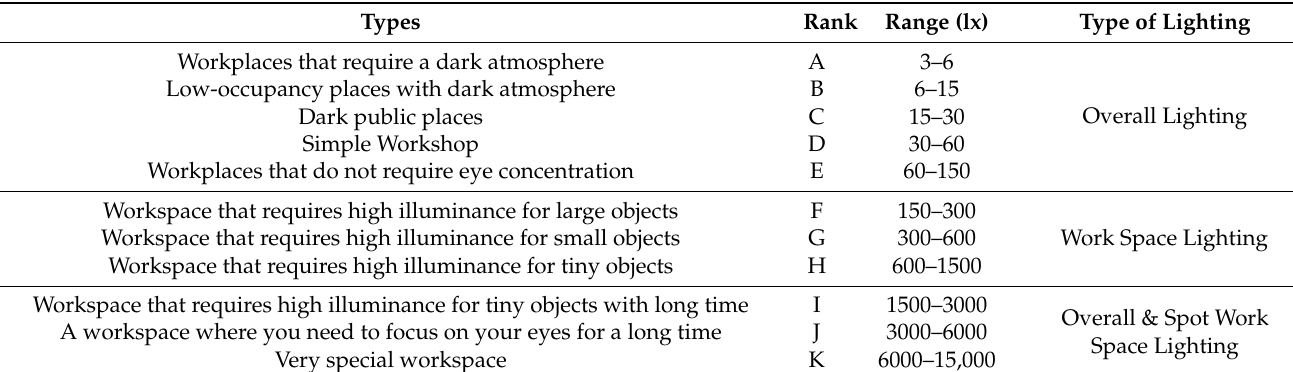
Table 1. Part of the KS A 3011 standard